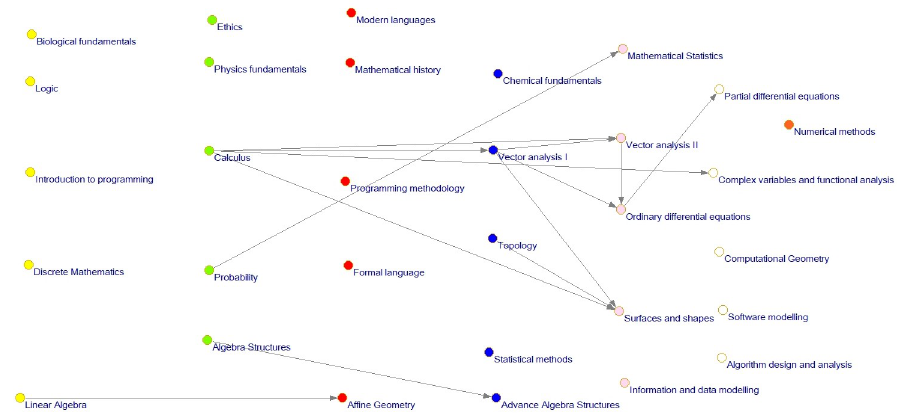
Fig 10. Curriculum network level 3 influence relation.